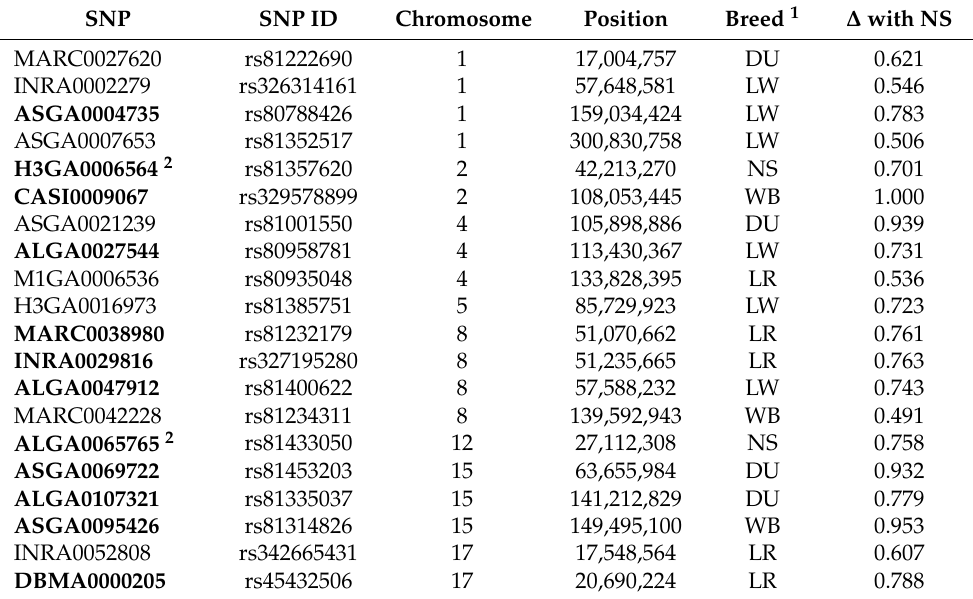
Table 1. Panel of 20 SNPs selected using statistical delta. Position refers to Sscrofa 10.2 assembly. The 12 SNPs used to discriminate Nero Siciliano breed from commercial breeds and Wild Boar are